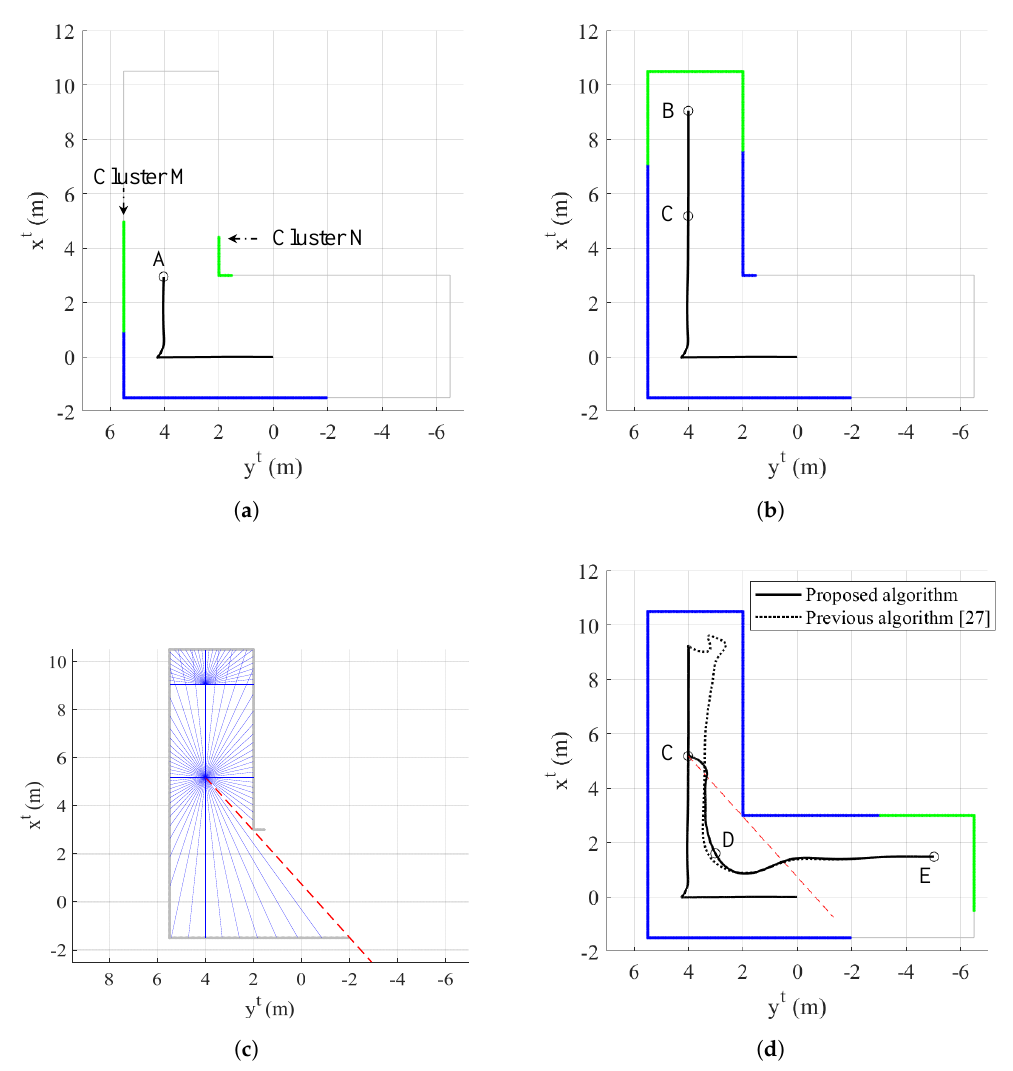
Figure 8. Simulation II result: ( a ) trajectory of the quadrotor and mapping at t = 12.0 s (top view, tangent–plane coordinate system); ( b ) trajectory of the quadrotor and mapping at t = 19.8 s (top view, tangent–plane coordinate system); ( c ) exploration completion check at t = 19.8 s; and ( d ) trajectory of the quadrotor and mapping at t = 47.0 s (top view, tangent–plane coordinate